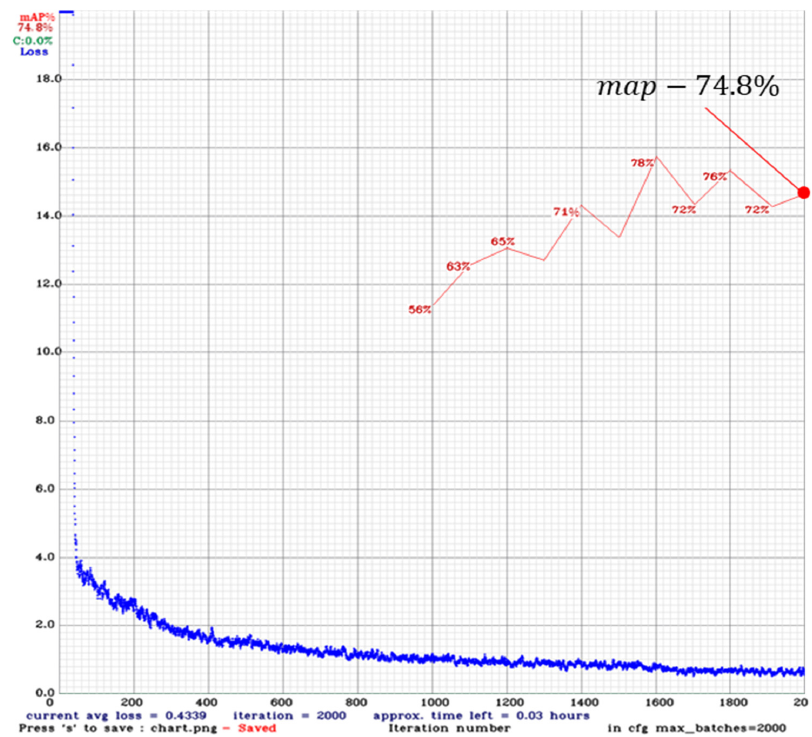
Figure 7. YOLOv2 training graph.